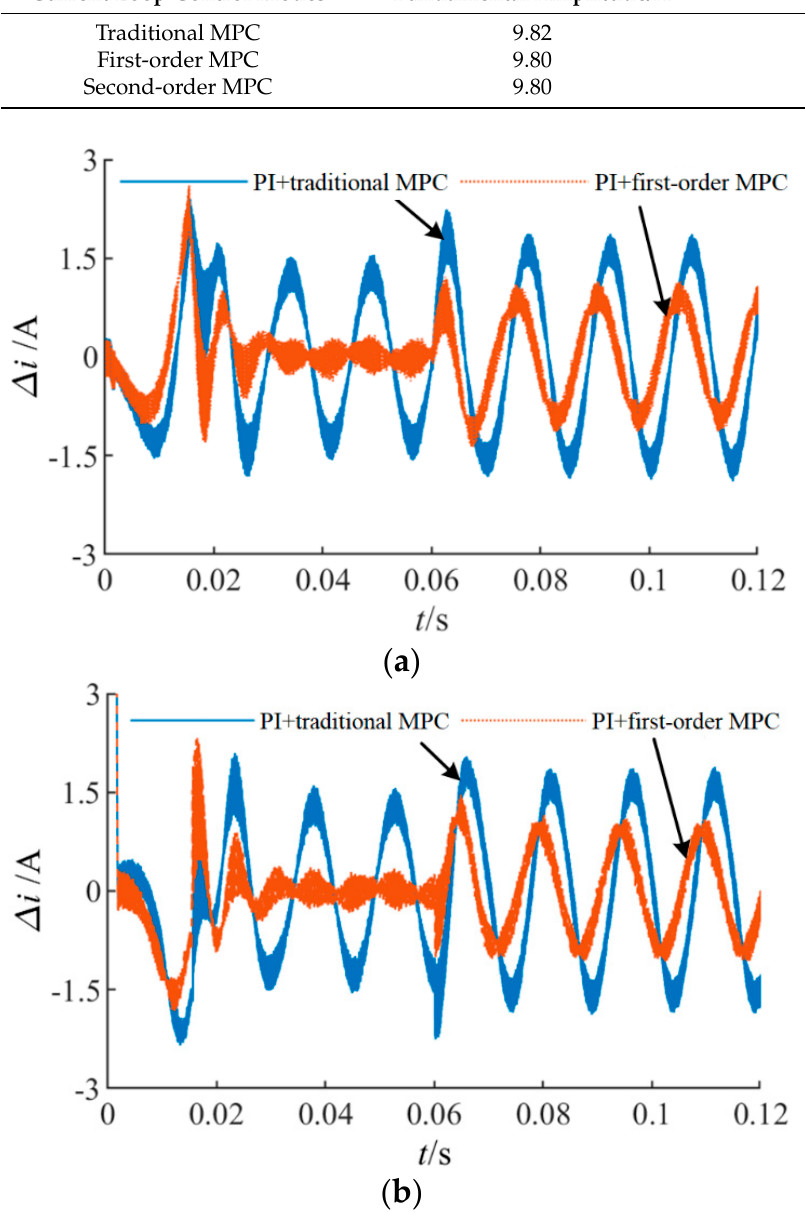
Figure 7. Current comparison waveforms of two control modes. ( a ) α -axis current comparison; ( b ) β -axis current comparison.